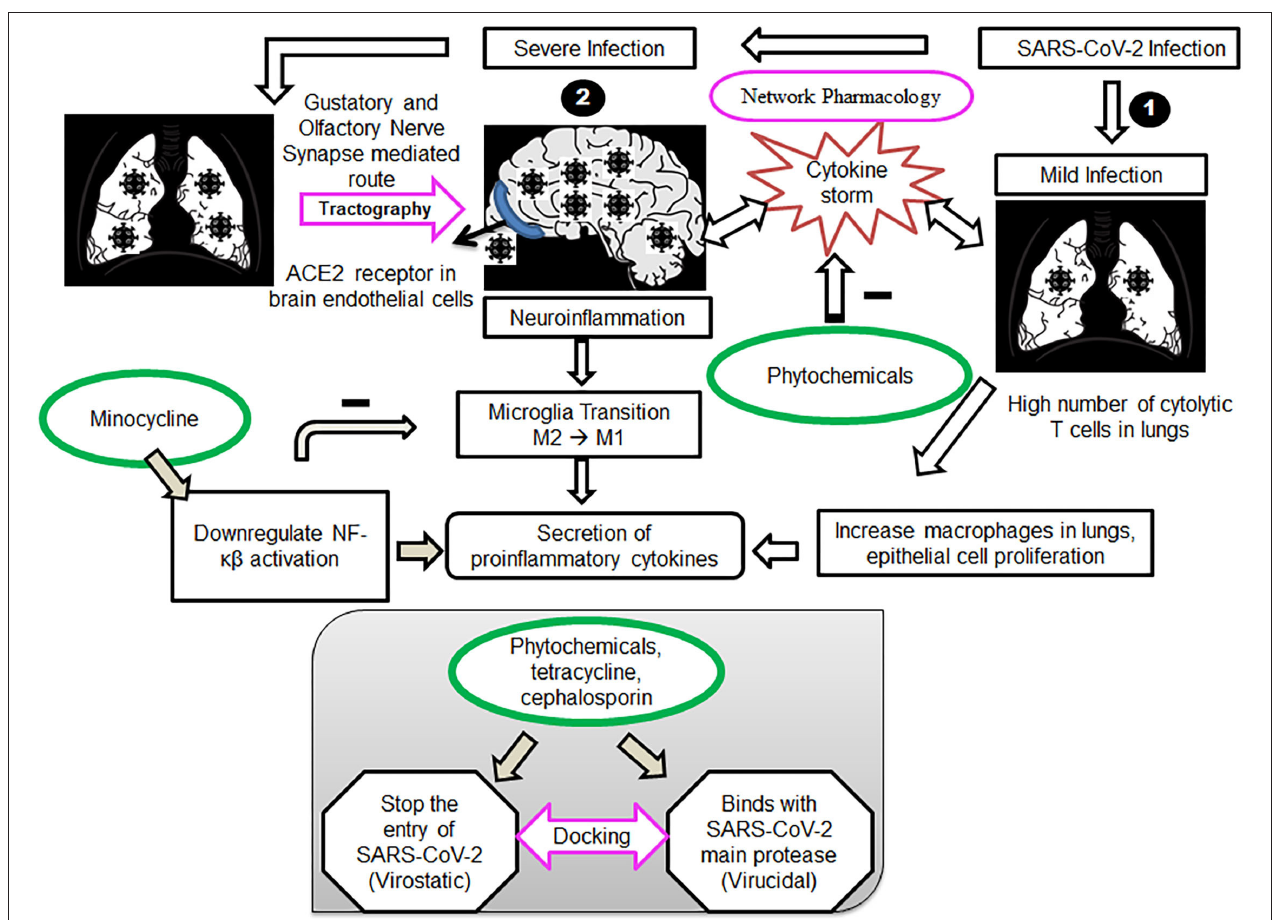
FIGURE 1 | Cell signaling pathways during mild and severe infections with SARS-COV2 and proposed therapeutic intervention of phytochemicals, tetracycline and cephalosporin ligands. (1) Mild infection with SARS-COV2, mainly lungs get affected, causing a high number of cytolytic T cells in the lungs. Phytochemicals act by targeting the T cells and monocytes, driving the cytokine storm in patients, leading to neuroinflammation. (2) Severe infection with SARS-COV2, affecting both lungs and the brain. Virus transmitting through a gustatory and olfactory nerve (tractography)-mediated route, causing neuroinflammation alleviated by Minocycline. Docking studies of phytochemicals, tetracycline and cephalosporin ligands, with the SARS-COV2 spike receptor-binding domain and main protease verify our